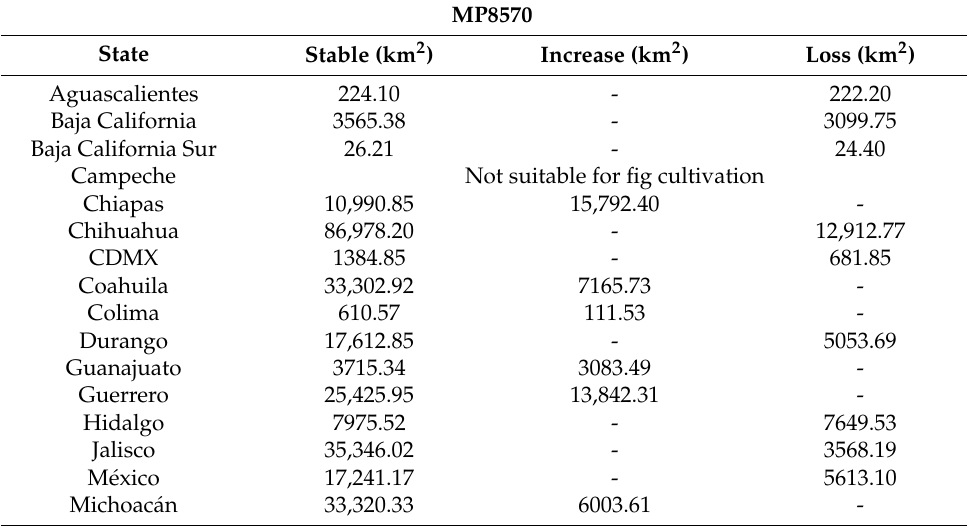
Table A8. Area estimated of fig crop for the year 2070 for the MPI-ESM-LR Model with RCP